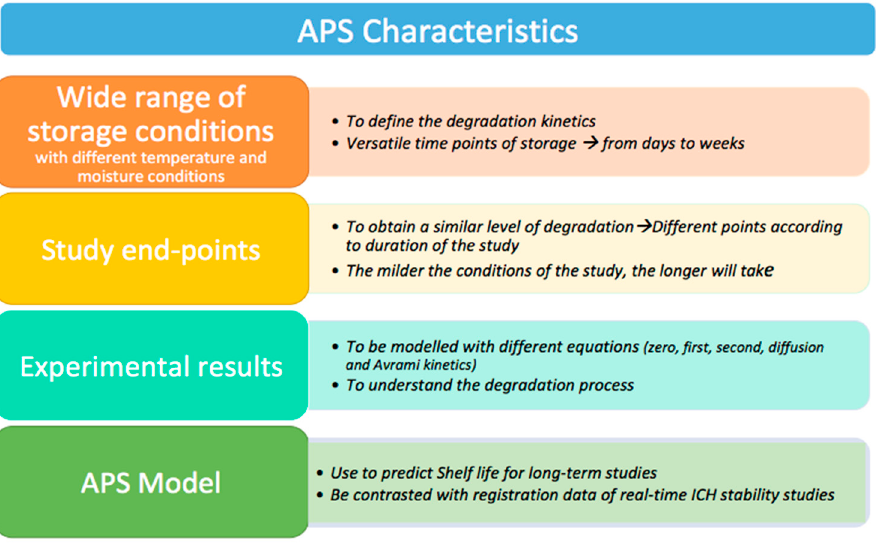
Figure 5. APS characteristics. Modified from: [16,17].